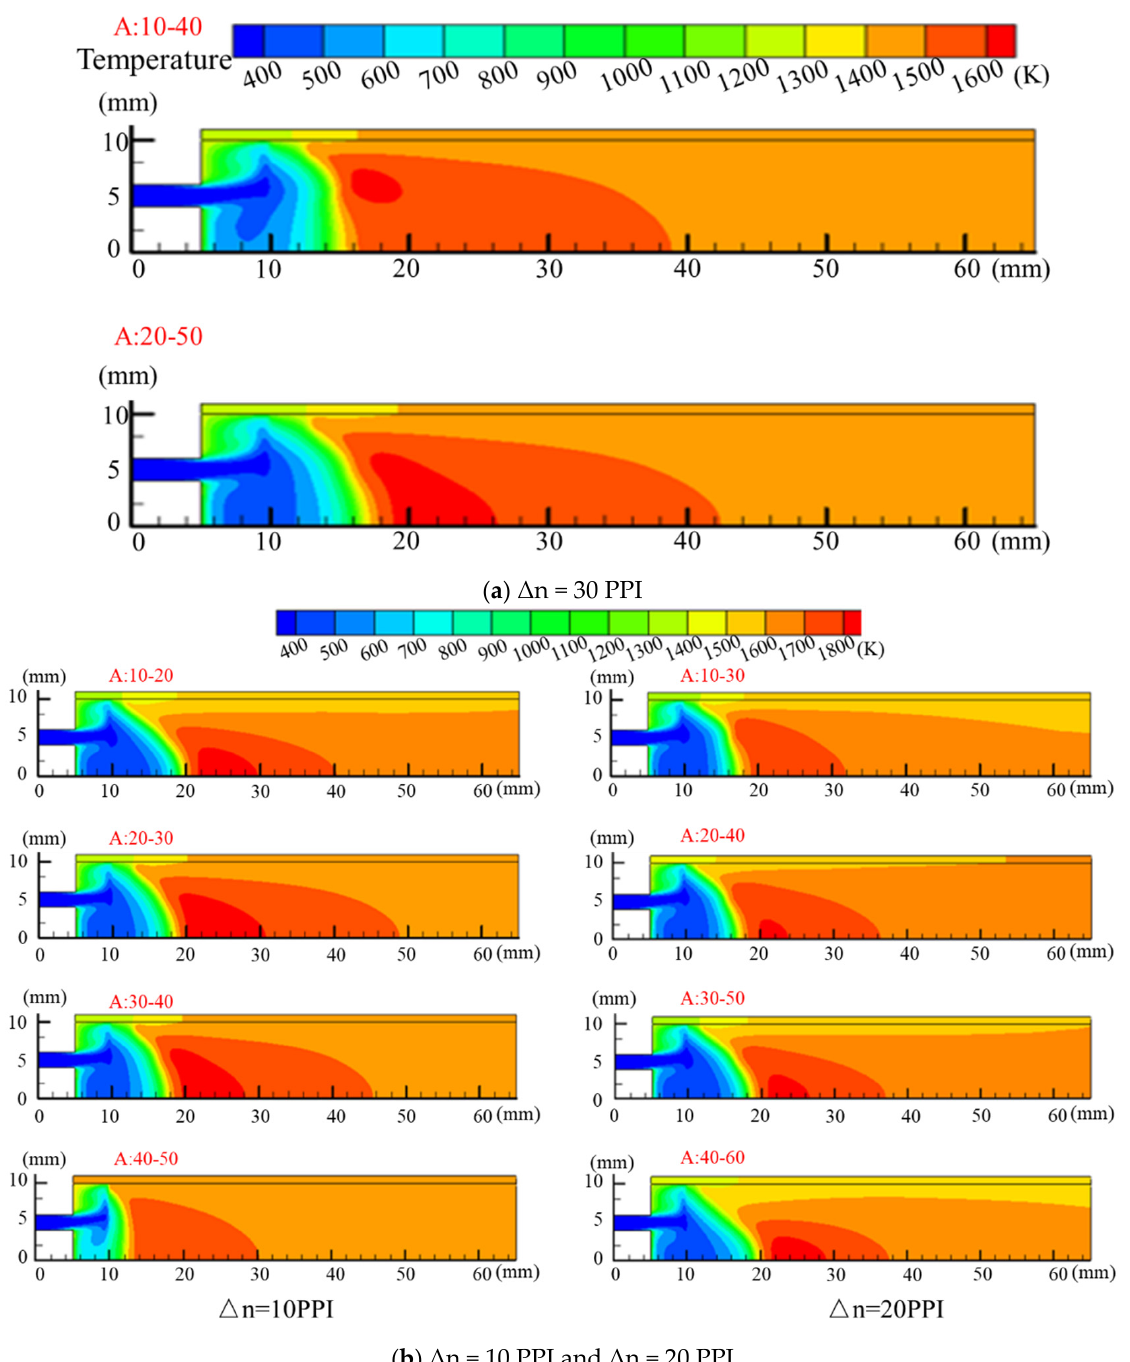
Figure 11. Temperature distribution with different Δ n.